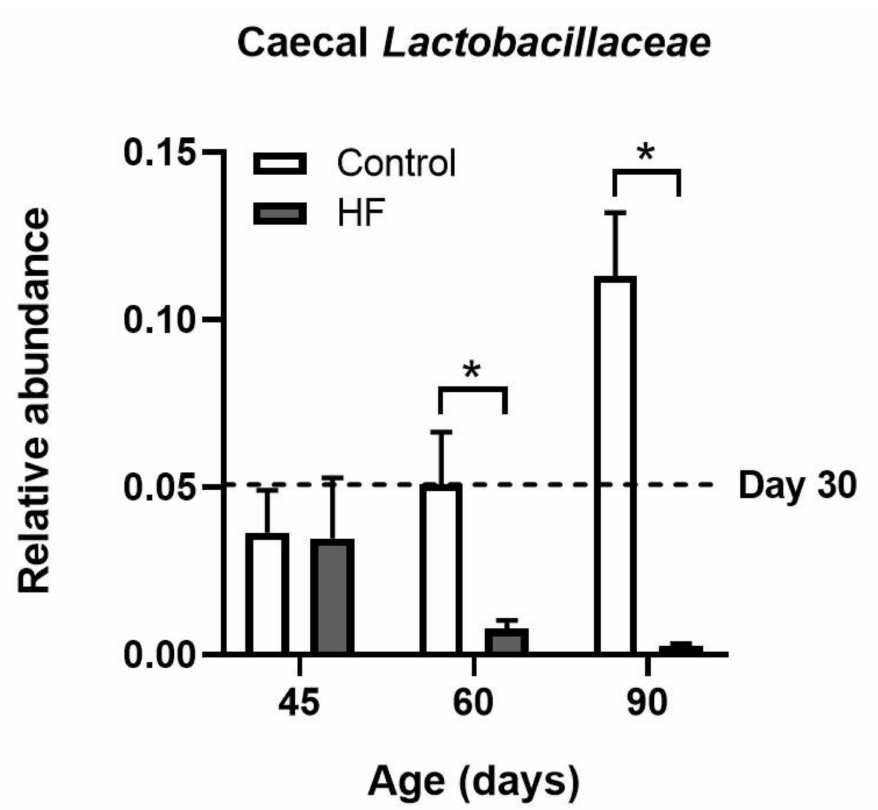
Figure 3. Relative abundance of Lactobacillaceae family in the caecal contents of rats under high fat (HF) diet. Rats received a diet containing 62% calories from fat from postnatal day 30 onwards. Age-matched controls were fed regular chow containing only 14% calories from fat. Bacterial DNA isolated from caecal contents was subjected to sequencing directed against the V3-V4 region of 16S rRNA gene, using an Illumina MiSeq platform. * p < 0.05 by PERMANOVA, n = 5. Original data from Alejandra Lopez-Aguilera and Johana Eyzaguirre-Vel á